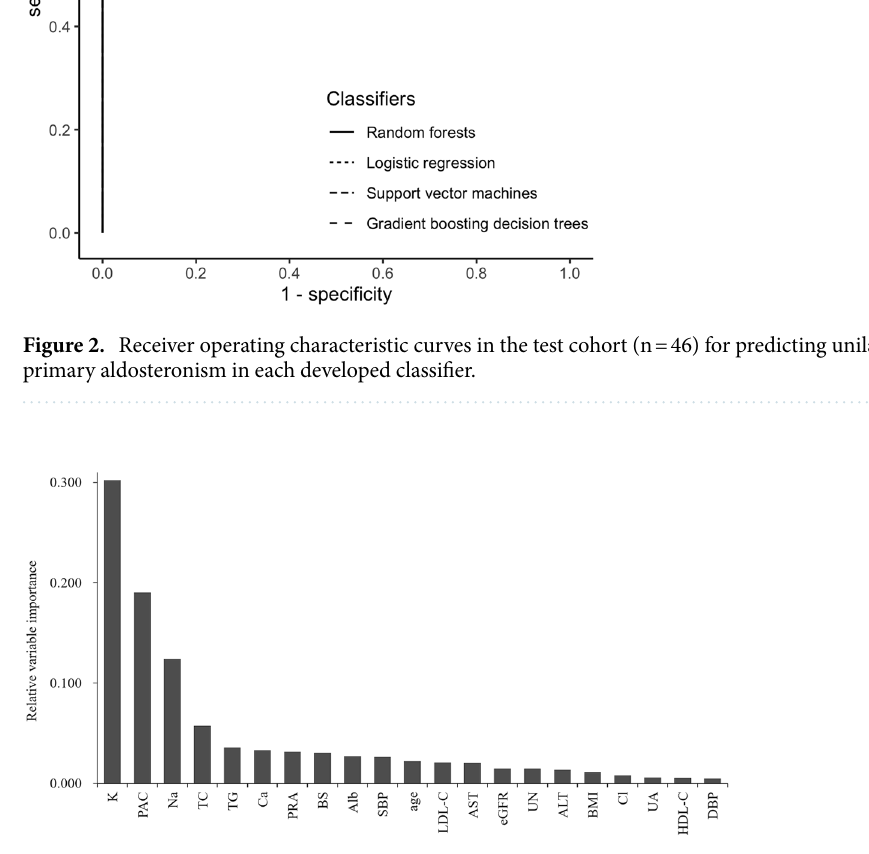
Figure 3. Relative variable importance for predicting unilateral subtype of primary aldosteronism calculated by random forests using 21 clinical data. The relative importance of each variable was arranged in descending order from left to